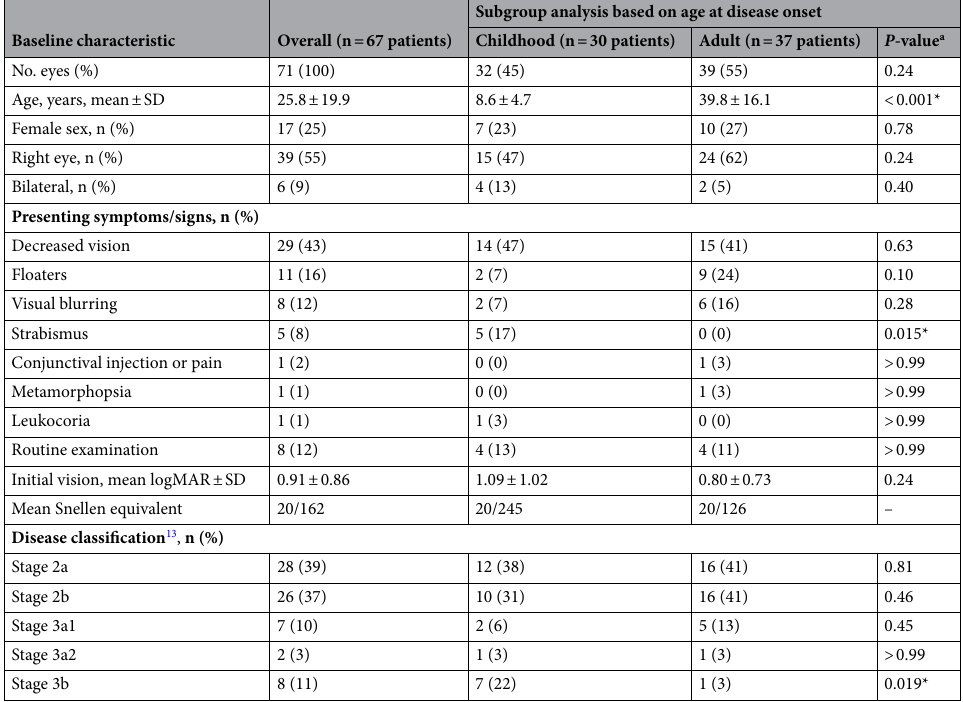
Table 1. Baseline characteristics of patients with Coats’ disease. LogMAR logarithm of minimum angle of resolution. * P -values of < 0.05 are considered statistically significant. a The chi-squared test and Student’s